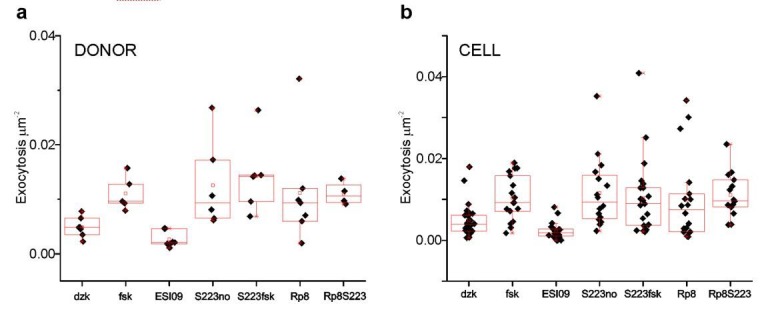
K+-stimulated exocytosis in the indicated conditions.In (a) each symbol represents the average of a donor, in (b), each symbol represents one cell.